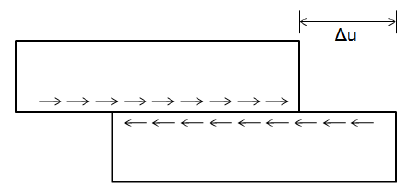
Figure 2 . Goodman model schematic diagram Figure 2. Goodman model schematic